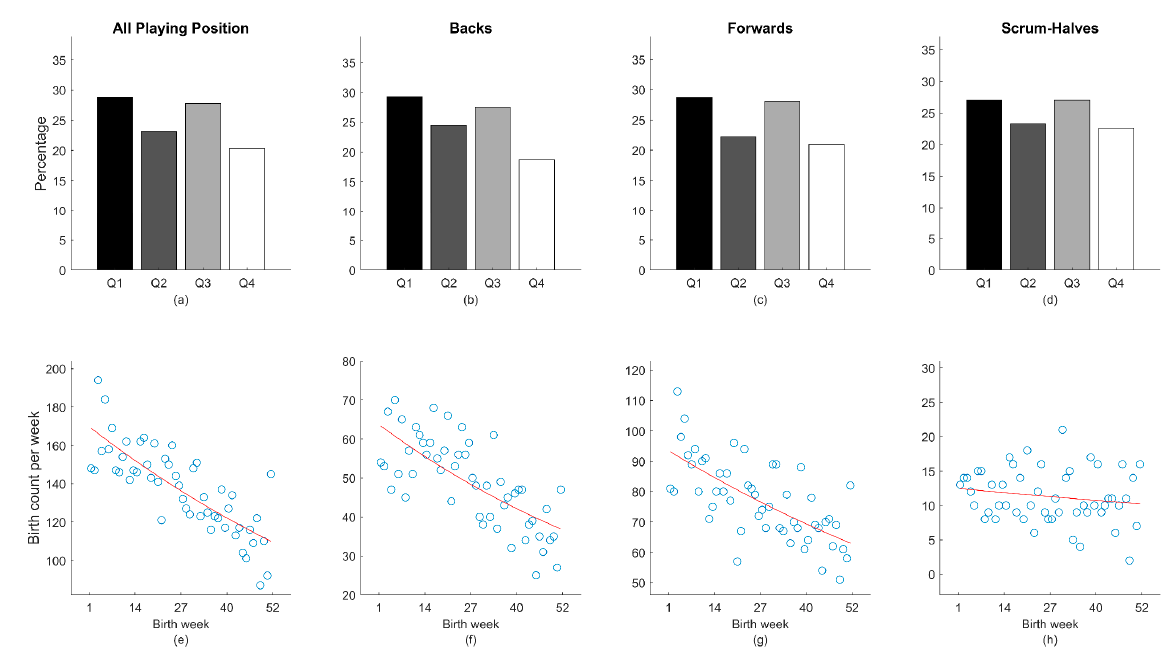
Figure 1. Birth quartile percentage distributions ( a – d ) and a scatterplot of birthdate frequency by week ( e – h ) presented individually for all playing positions, backs, forwards, and scrum-halves. The red line represents the best fit of the Poisson regression.